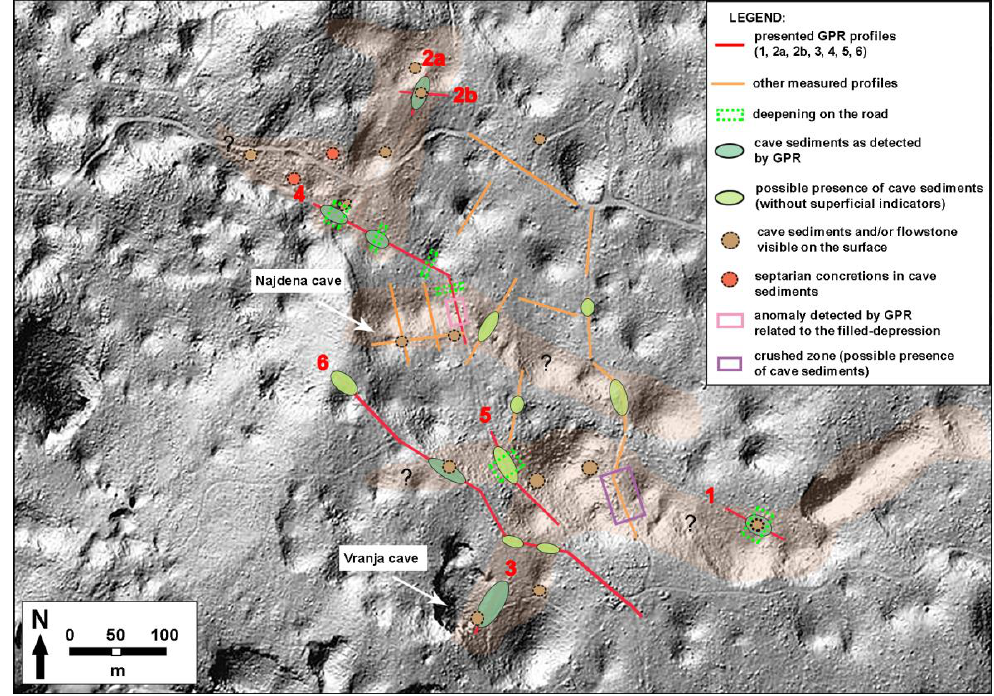
Figure 18. Profiles with interpreted anomalies detected by GPR and the occurrences of the superficial indicators of cave sediments.